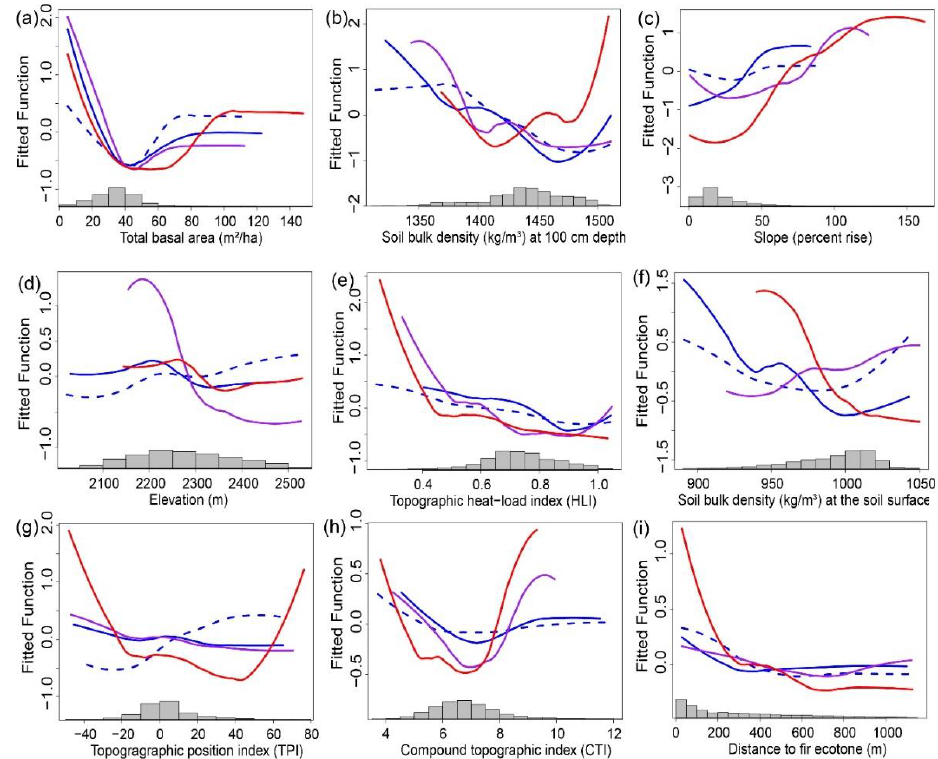
Figure 5. Partial-dependence plots from boosted regression tree models depicting the relationships between landscape characteristics and probability of refugium occurrence in 2001 (dashed lines) and 2009 (solid lines), in lodgepole pine forest (blue), lodgepole–whitebark pine forest (purple), and whitebark pine forest (red). Plots represent loess-smoothed averages across 20 independent bootstrapped model runs using a random subsample of 2000 grid cells for each forest type in each model run (Appendix F). Higher values on the vertical axes indicate greater probability of a grid cell being identified as a refugium. Histograms at the bottom of each plot indicate distributions of landscape characteristics across all grid cells in the study area used for modeling.